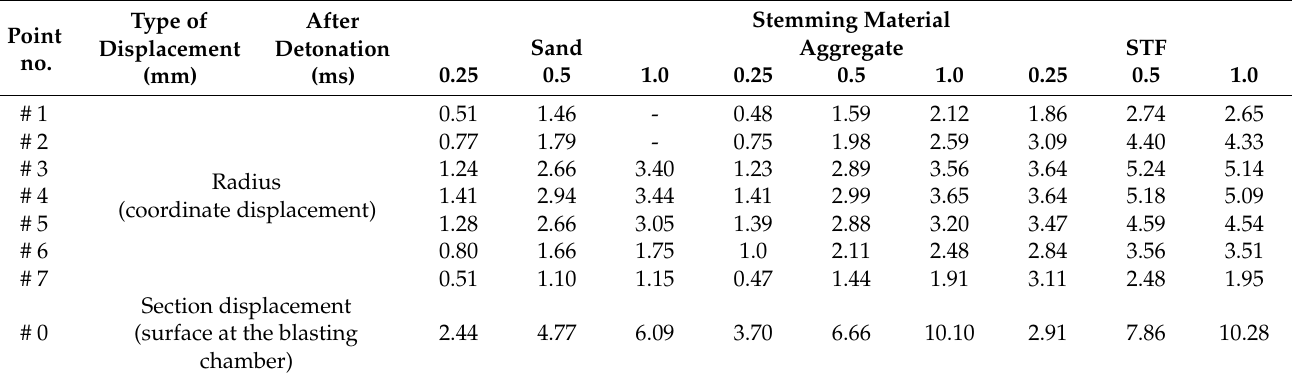
Table 6. Measurement points of high-speed